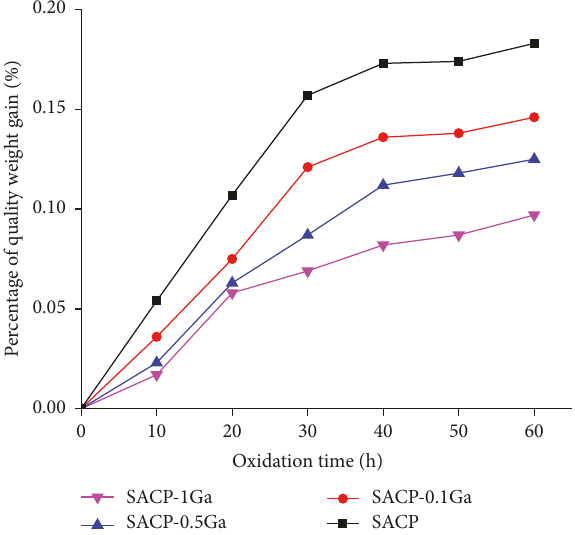
Figure 8: The oxidation weight gain curves of the